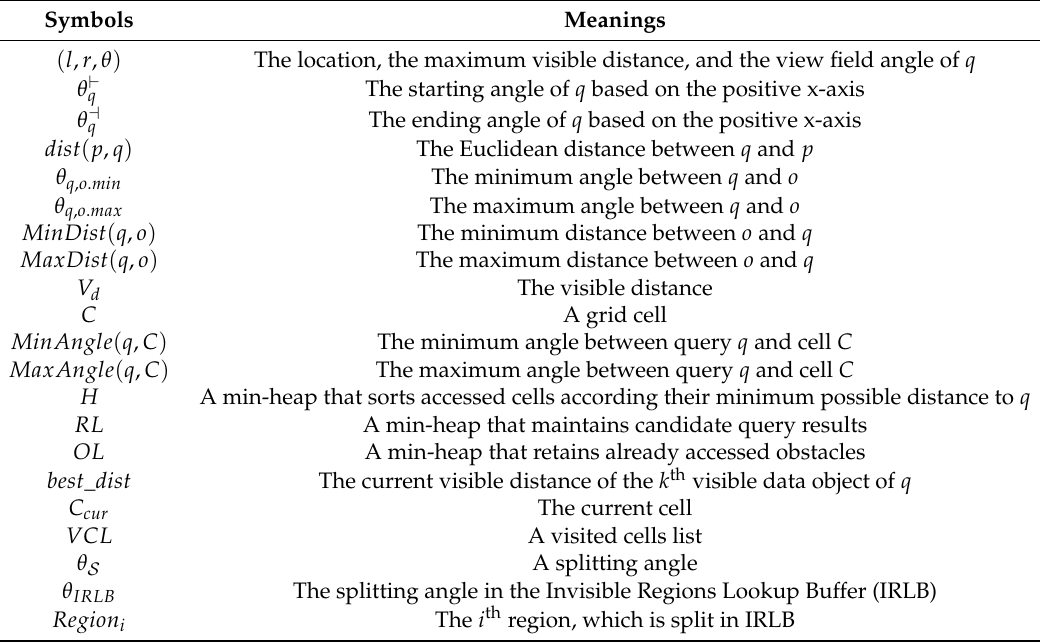
Table 1. Summary of